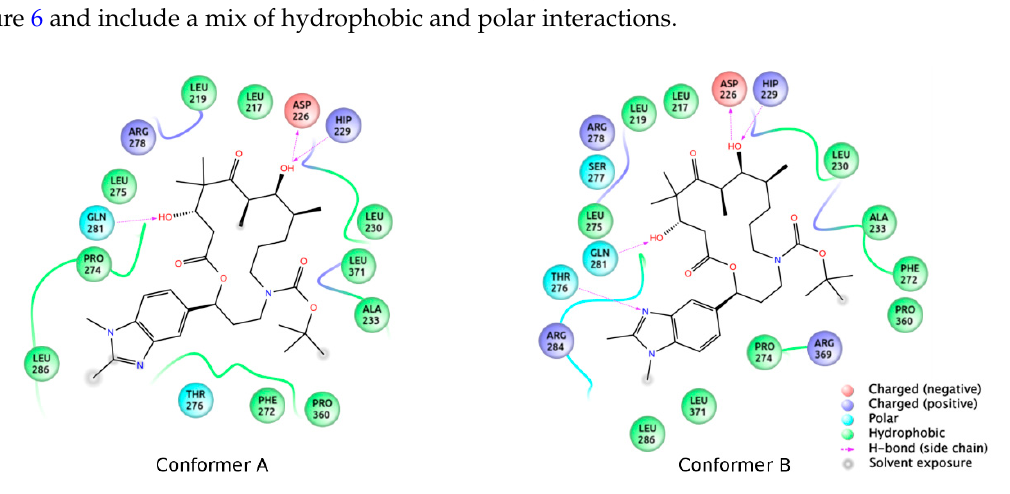
Figure 6. Key intermolecular contacts between tubulin and azathilone 2 .